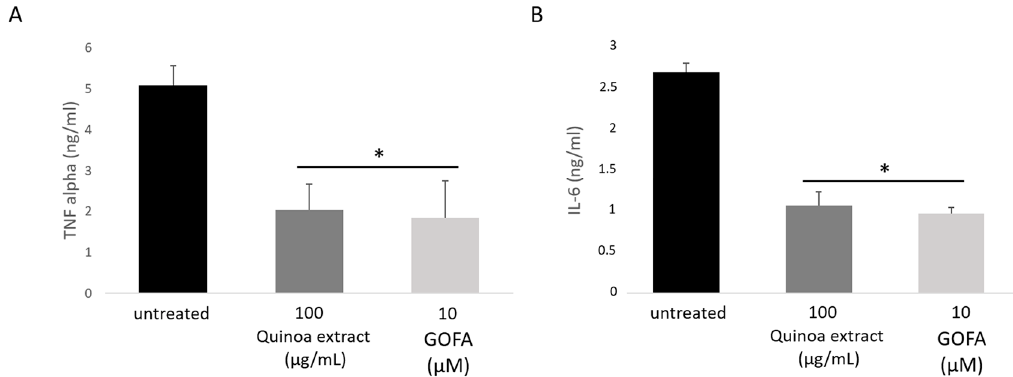
Figure 5. The effect of quinoa extract and GOFA on TNF- α and IL-6 production in HCT-116 cells. TNF- α ( A ) and IL-6 ( B ) levels were measured by ELISA. Values are means standard deviations; n = 3, * p < 0.05 vs. untreated cells.